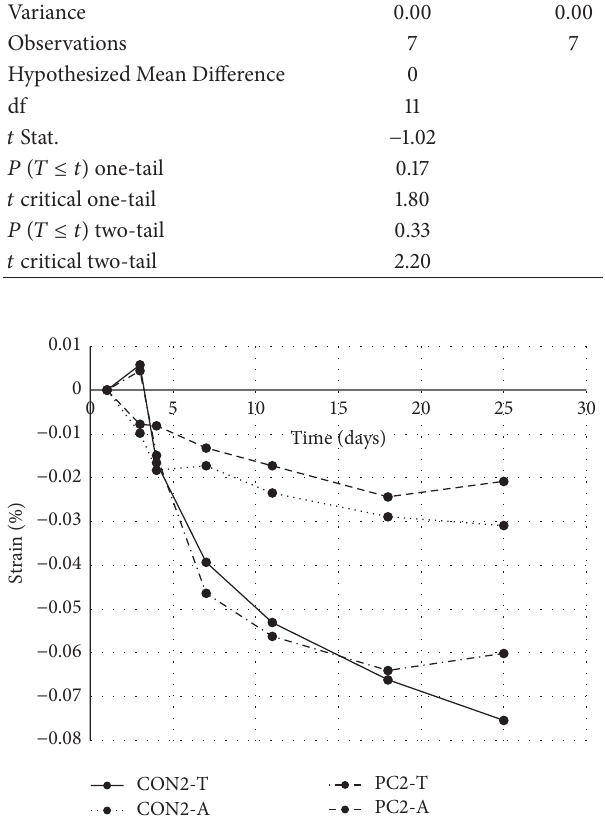
Figure 2: Total and autogenous shrinkage of Portland and green cement mortar